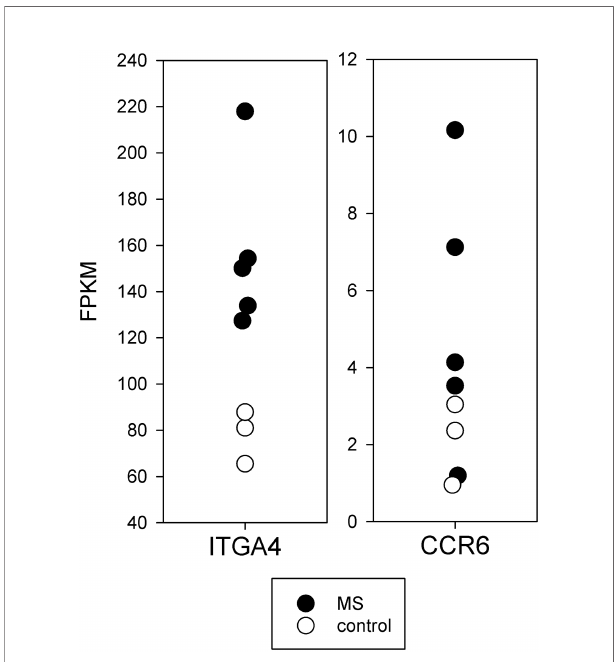
FIGURE 5 | Expression of mRNA important for CNS entry in brain-stimulated cells from MS and controls. The mRNA for integrin- a 4 required for T-cell entry into the CNS (ITGA4) was increased in MS ( p <